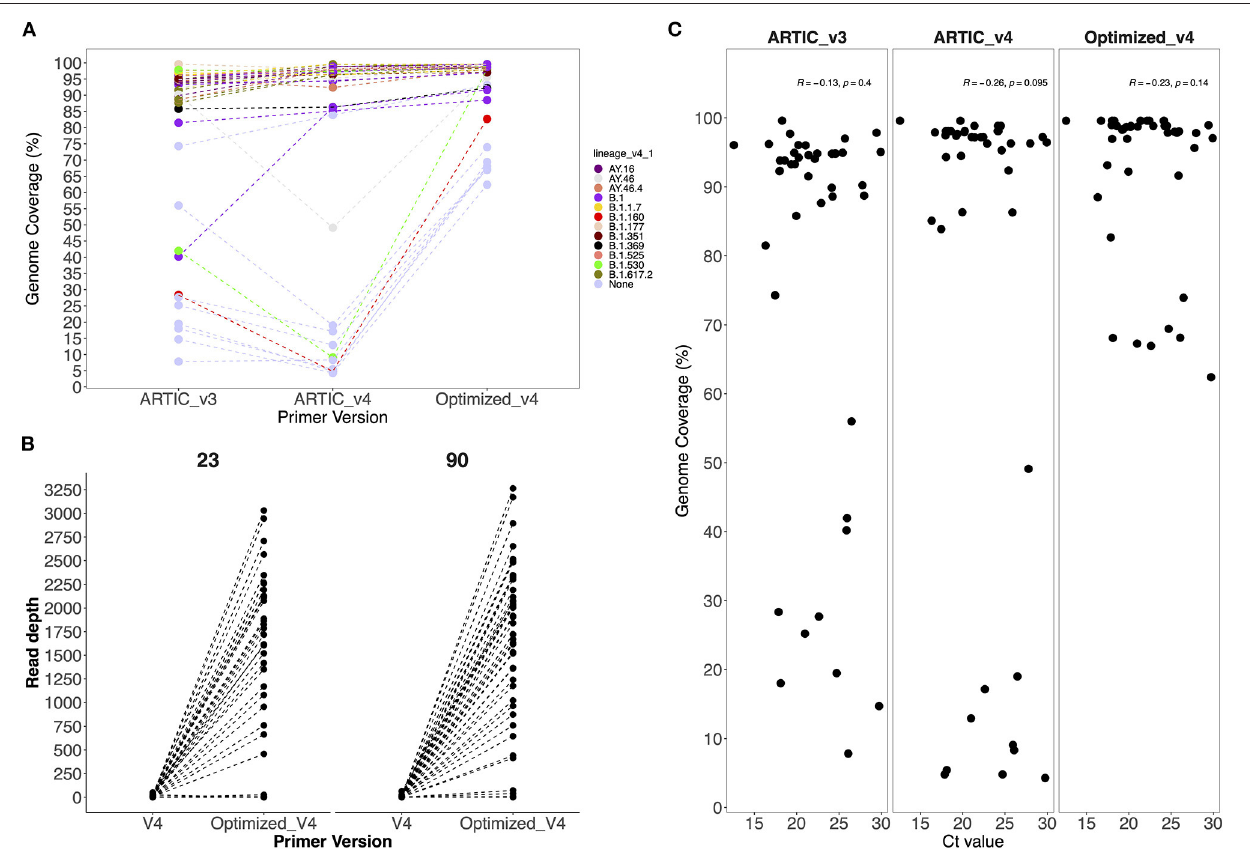
FIGURE 2 | (A) Comparison of genome coverage across all sequences generated by the V3, V4 and optimized V4 primers and (B) Comparison of the average amplicon depth from amplicons 23 and 90 when using V4 and optimized V4 primers. Primer version is on the x-axis and amplicon depth on the y-axis. (C) Comparison of Ct values against genome coverage for V3, V4 and optimized V4 primer sets. Each dot represents a sample whose Ct value is highlighted in the x